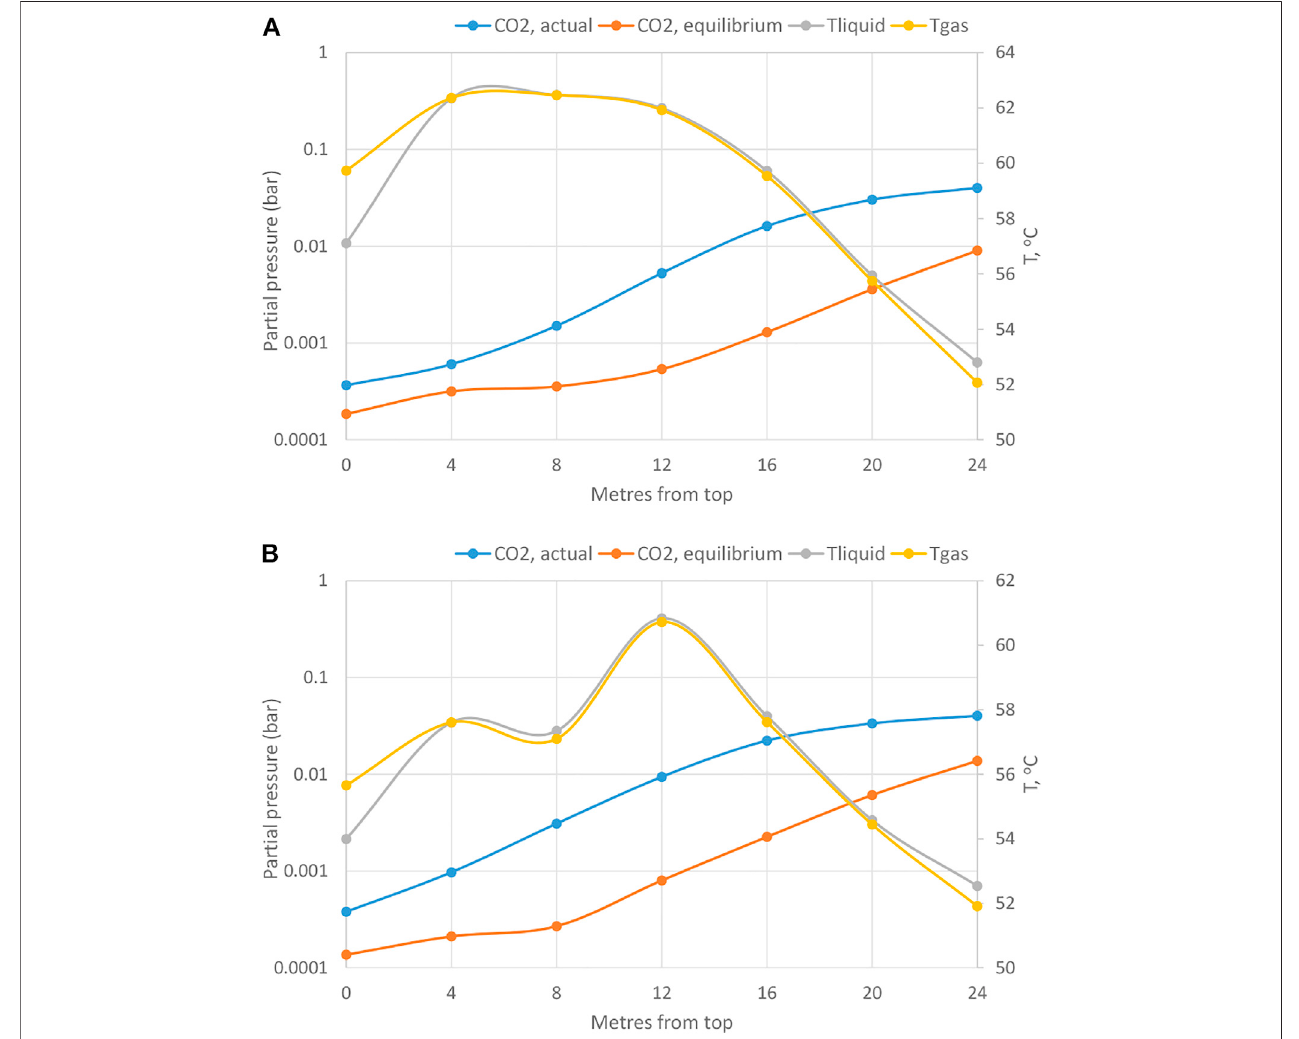
FIGURE 12 | Actual and equilibrium CO 2 partial pressures and Temperature pro fi les along the absorber for 24 m packing height, capture level of 99% and lean loading of 0.14 molCO 2 /molMEA [ (A) no intercooling, (B) intercooling temperature = 35 °